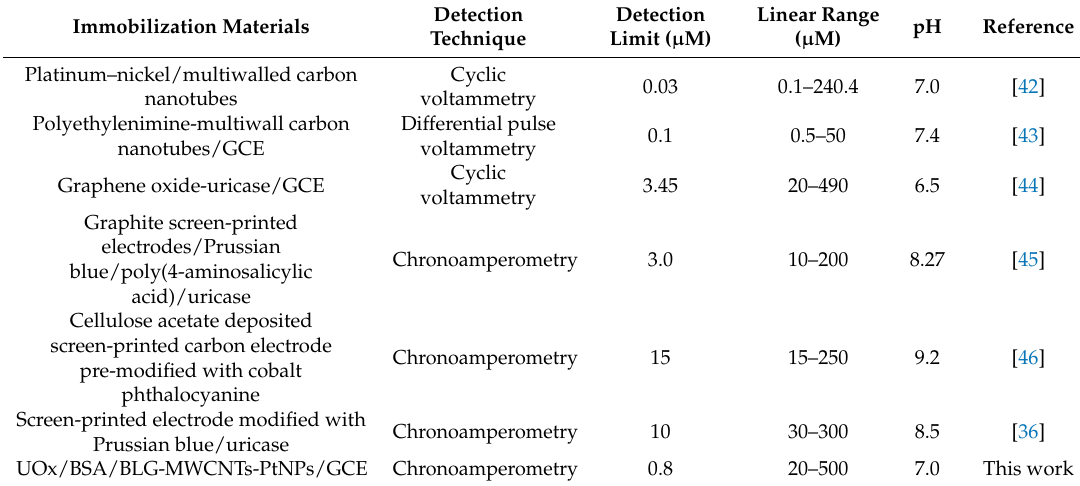
Table 1. Characteristics of various amperometric uric acid